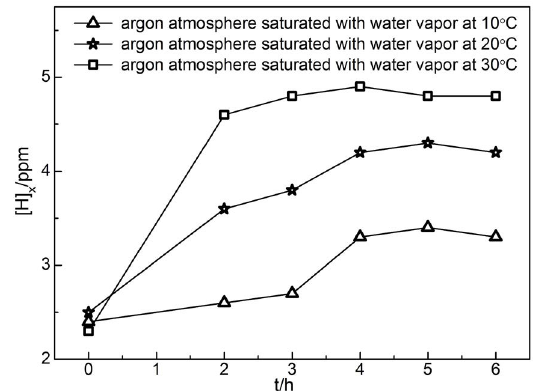
Figure 3. Influence of atmospheric moisture on the hydrogen content in steel during